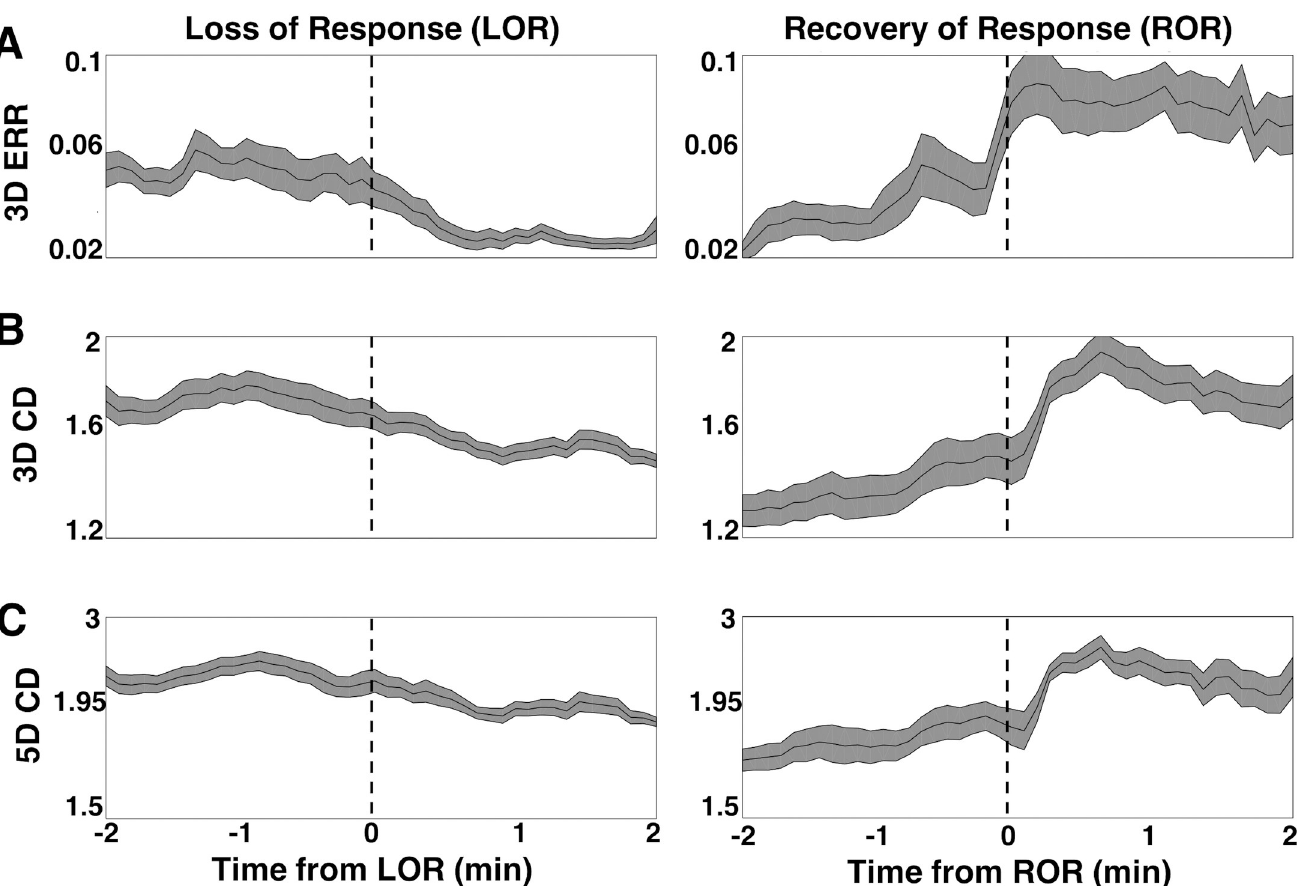
Fig 11. Dynamics of attractors during loss and recovery of response for the population studied. A) The average ellipse radius ratio (ERR) for all patients appears to decrease gradually as patients approach loss of response (LOR), and continues to decrease in value as anesthetic depth increases (A, left). In contrast ERR upon recovery (A, right) is marked by a more abrupt increase in ERR at the ROR transition point. B) The 3D correlation dimension (CD) gradually decreases during LOR (B, left) and more abruptly increases during ROR (B, right). C) The 5D correlation dimension (CD) gradually decreases during LOR (C, left) and more abruptly increases during ROR (C, right). Both the 3D CD ROR (B, right) and the 5D CD ROR (C, right) appear to lag behind the recovery timepoint (dashed line), while the ERR does not. Solid black lines represent the mean complexity values at each timepoint for all patients. Shaded area is the standard error of the mean. Vertical dashed lines represent the time of LOR or